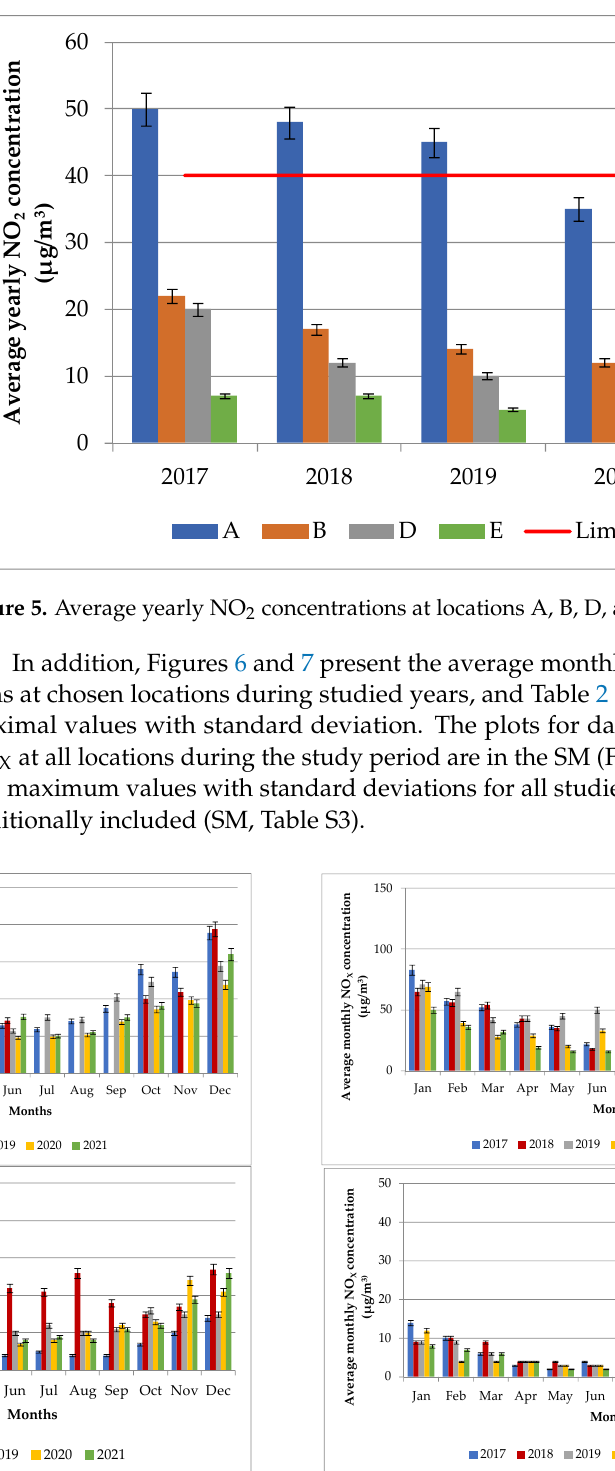
Figure 4. Average monthly NO 2 concentrations at locations A, B, D, and E between 2017 and 2021 (from left to right, from top to bottom). Figure 5 shows average annual NO 2 concentrations at studied locations between 2017 and 2021. Average annual NO 2 concentrations were the highest at location A (50.00 ± 2.50 µ g/m 3 ) in 2017, while the lowest were detected at location E (5.00 ± 0.25 µ g/m 3 ) in 2019, 2020, and 2021.